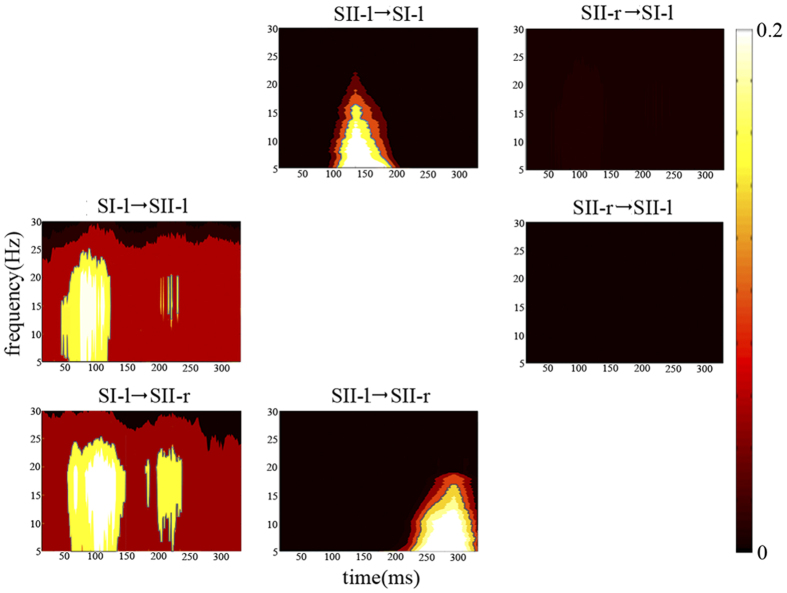
Time-frequency representations of rPDC as a measure of time-dependent Granger causal influences within the neural network between SI-l, SII-l and SII-r averaged across all the subjects. The regions circled by blue lines had significantly larger rPDC values than those in the reference interval from -100 ms to 0 ms (P < 0.01).